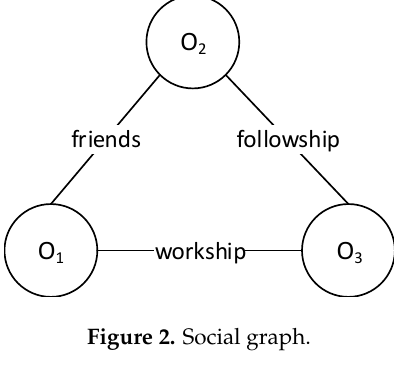
Figure 2. Social